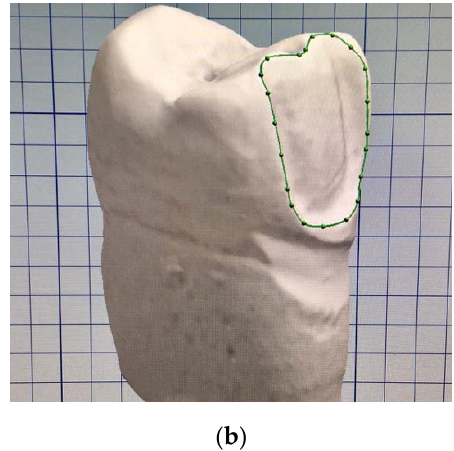
Figure 2. Veneer fabrication: ( a ) teeth fixed in putty silicone bases to ensure better control during scanning and cementation; ( b ) design of the veneers with the margin line marked (green line).